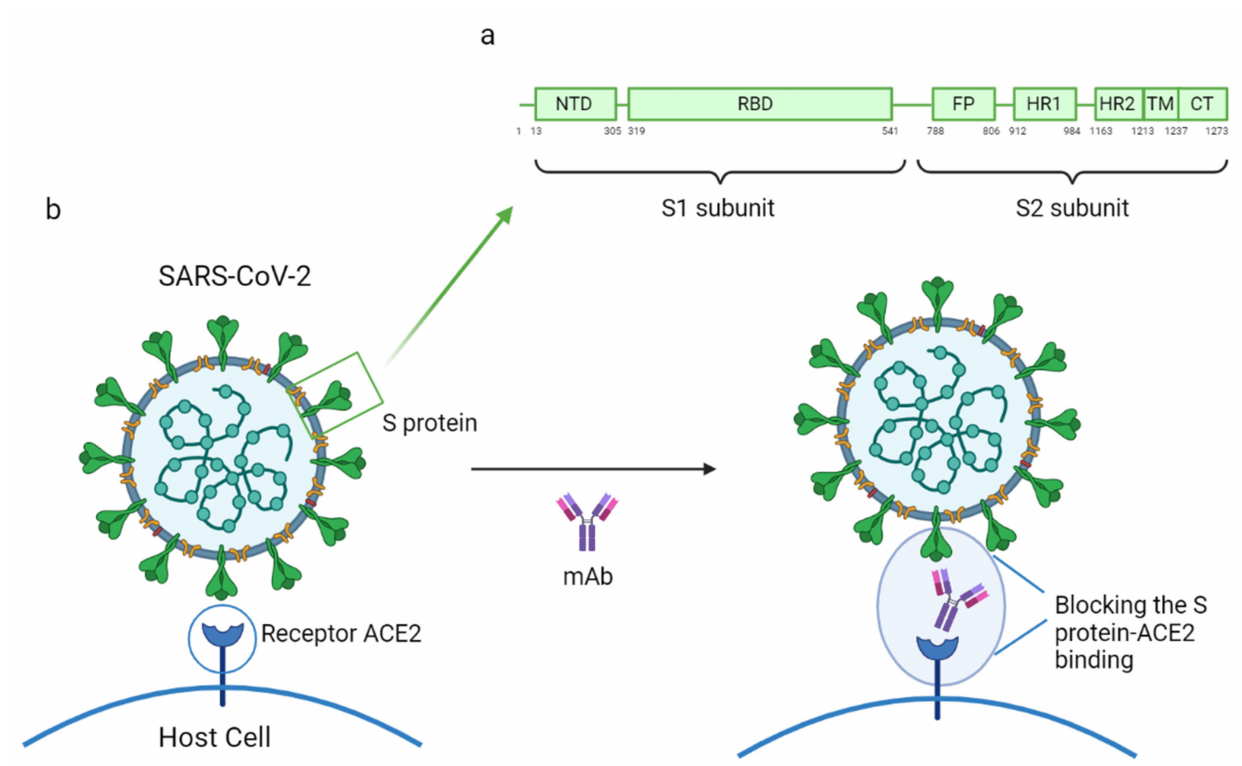
Figure 3. ( a ) Mechanism of action of a mAb by blocking the SARS-CoV-2 S protein and human ACE2 receptor binding; ( b ) structure of the SARS-CoV-2 S protein. This figure was composed using BioRender (available at: https://biorender.com/. Accessed on 12 May